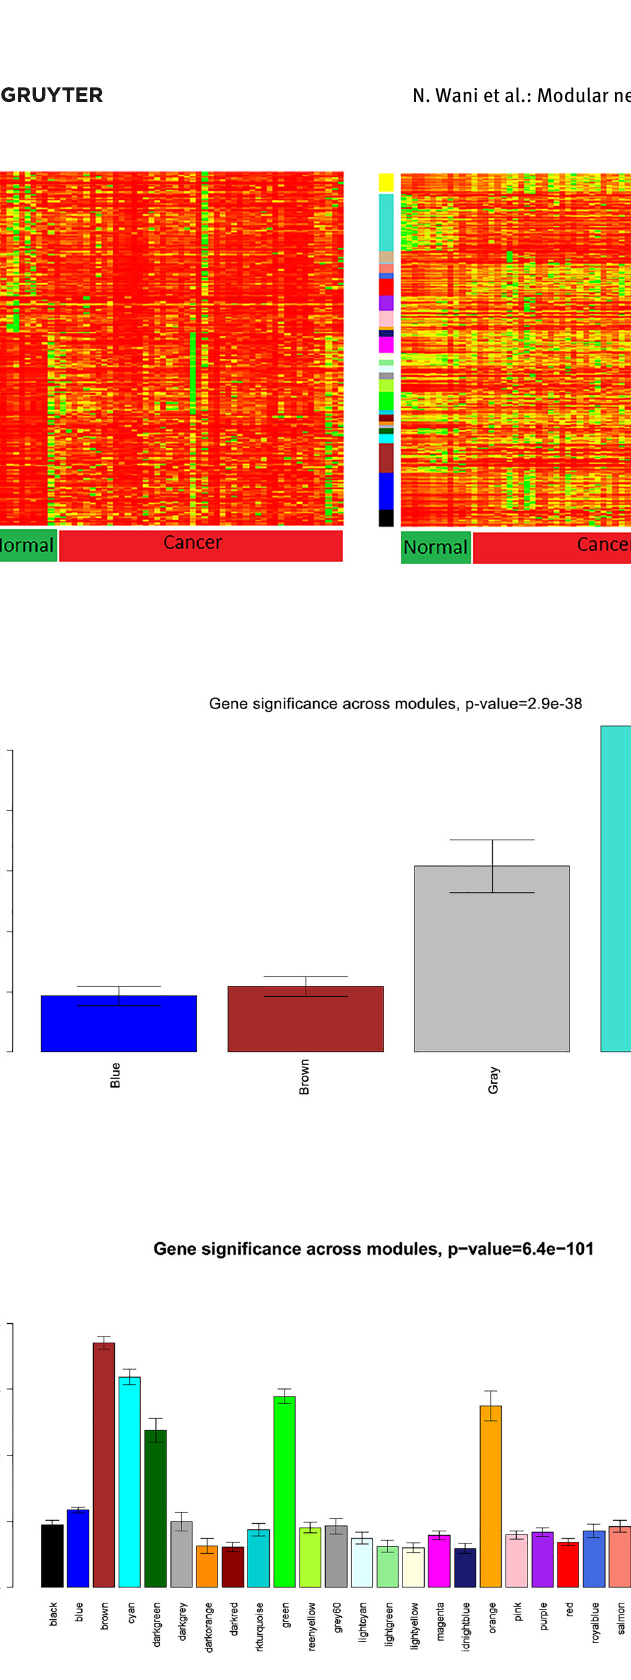
Figure 5: Gene significance of gene